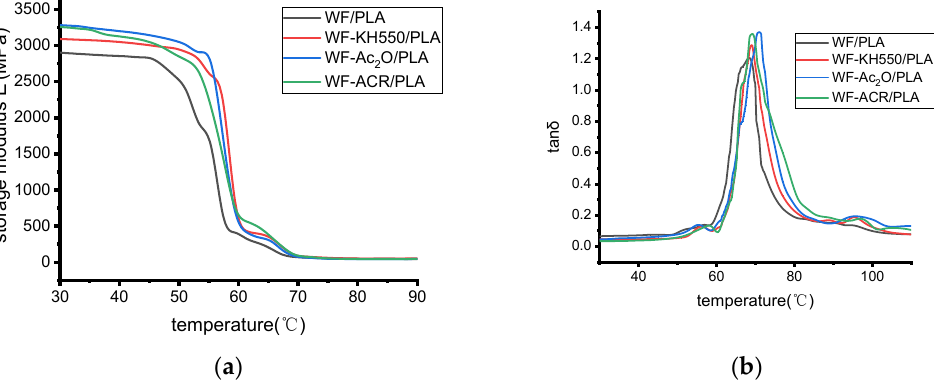
Figure 5. ( a ) Storage modulus and ( b ) loss angle tangent as a function of temperature for different printing samples. Table 2. Tg of unmodified and modified PLA/WF composites (Frequency: 5 Hz).